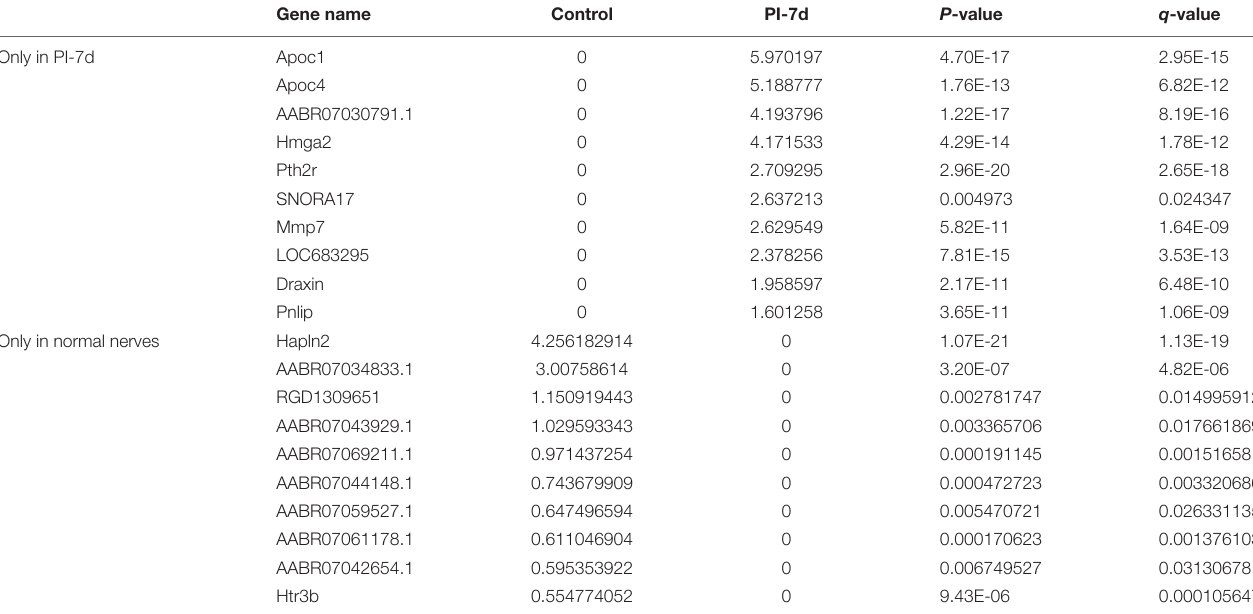
TABLE 4 | Top 10 DEmRNAs only expressed 7 days after crush injury (Post-Injury 7 days, PI-7d) or only expressed in normal sciatic nerves.